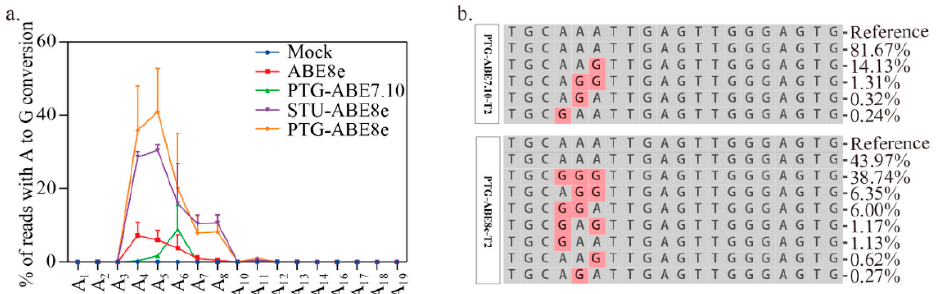
Figure 4. Editing window and editing outcome comparison between PTG-ABE7.10 and